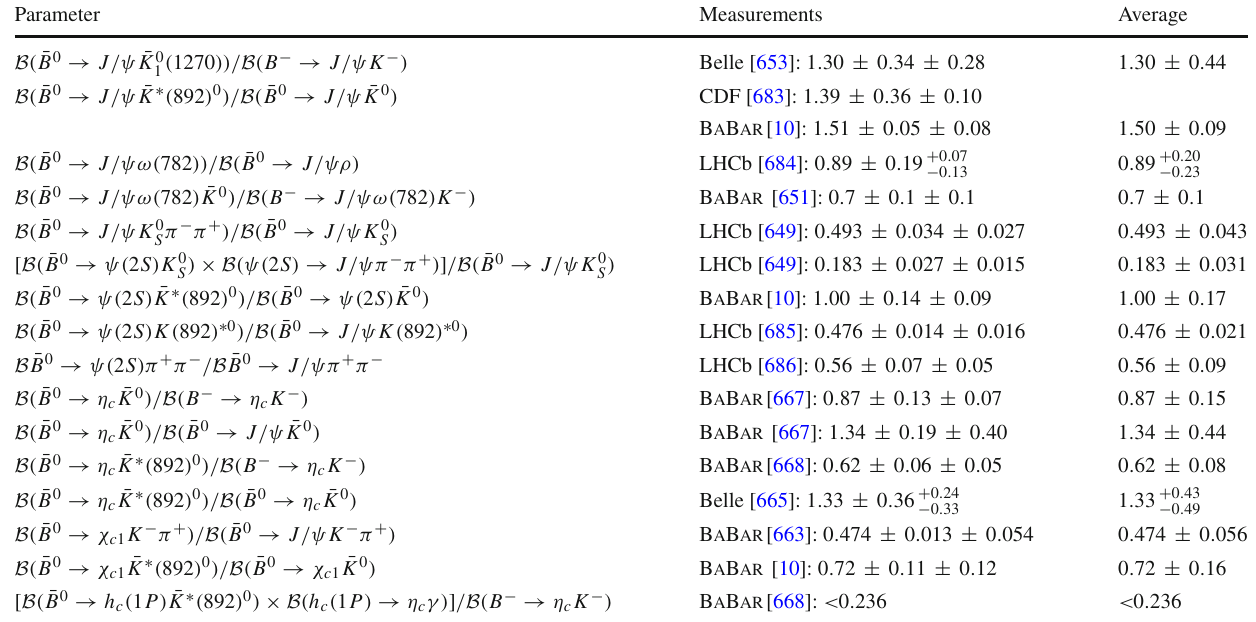
Parameter Measurements